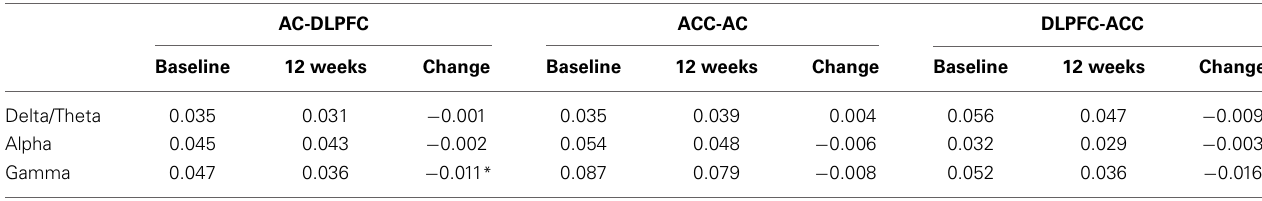
Table 2 | Coherence between selected regions for the selected frequency bands.